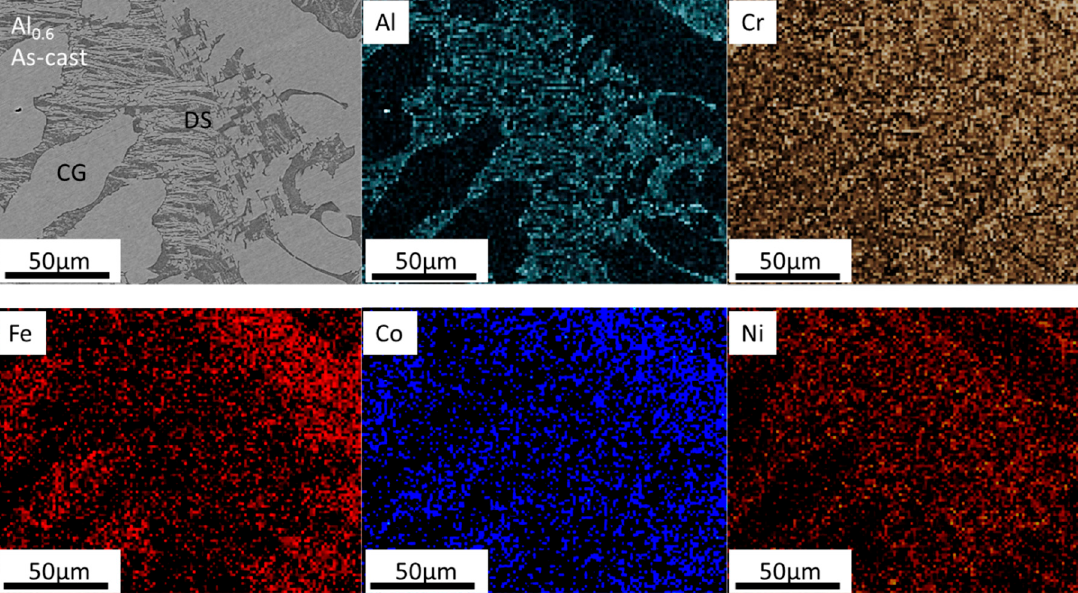
Figure 2. BSE SEM-micrograph and energy dispersive X-ray spectrometer (EDS)-mapping results of Al 0.6 in its as-cast state.